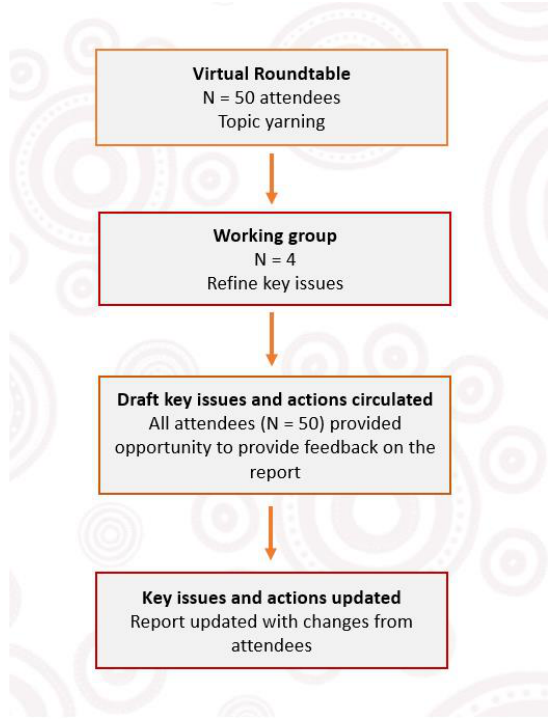
Figure 1. Roundtable Process flow chart.